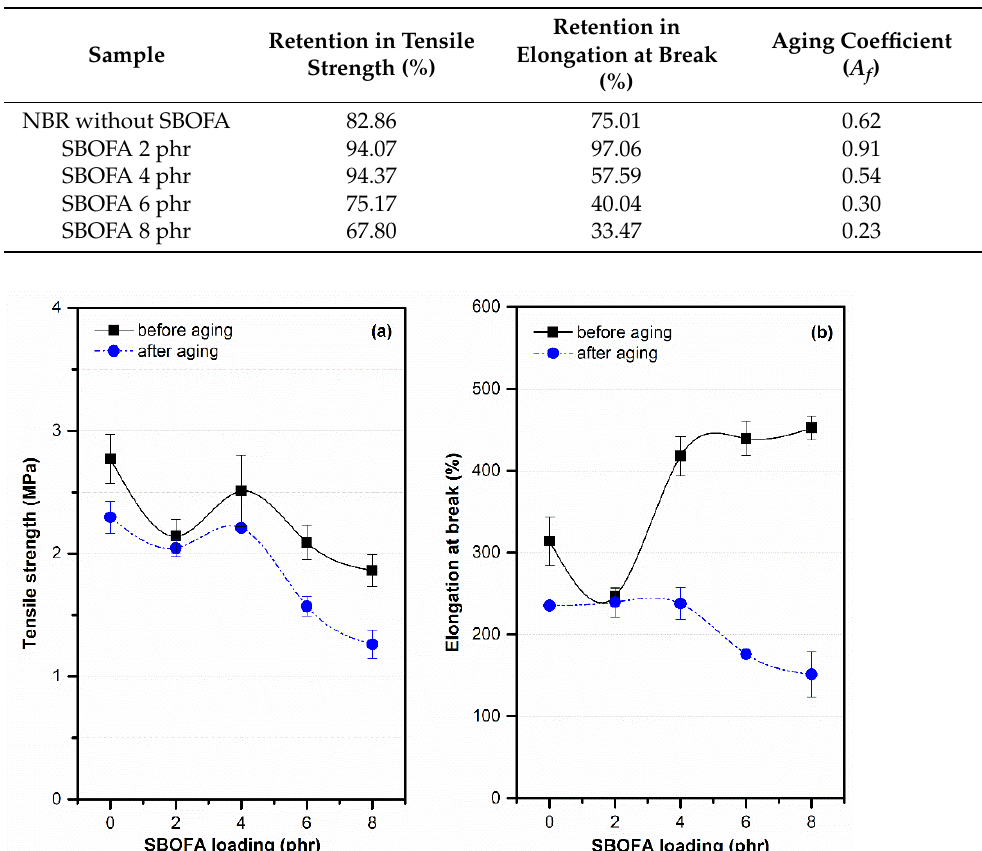
Table 7. Retention in mechanical properties (tensile strength and elongation at break) and aging coefficient (A f ) of the NBR vulcanizates with varying SBOFA loadings.